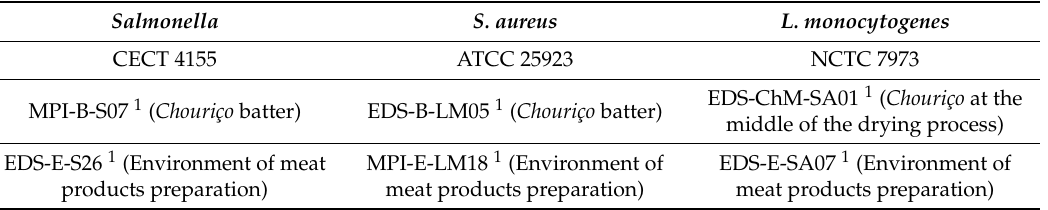
Table 1. Strains used in the